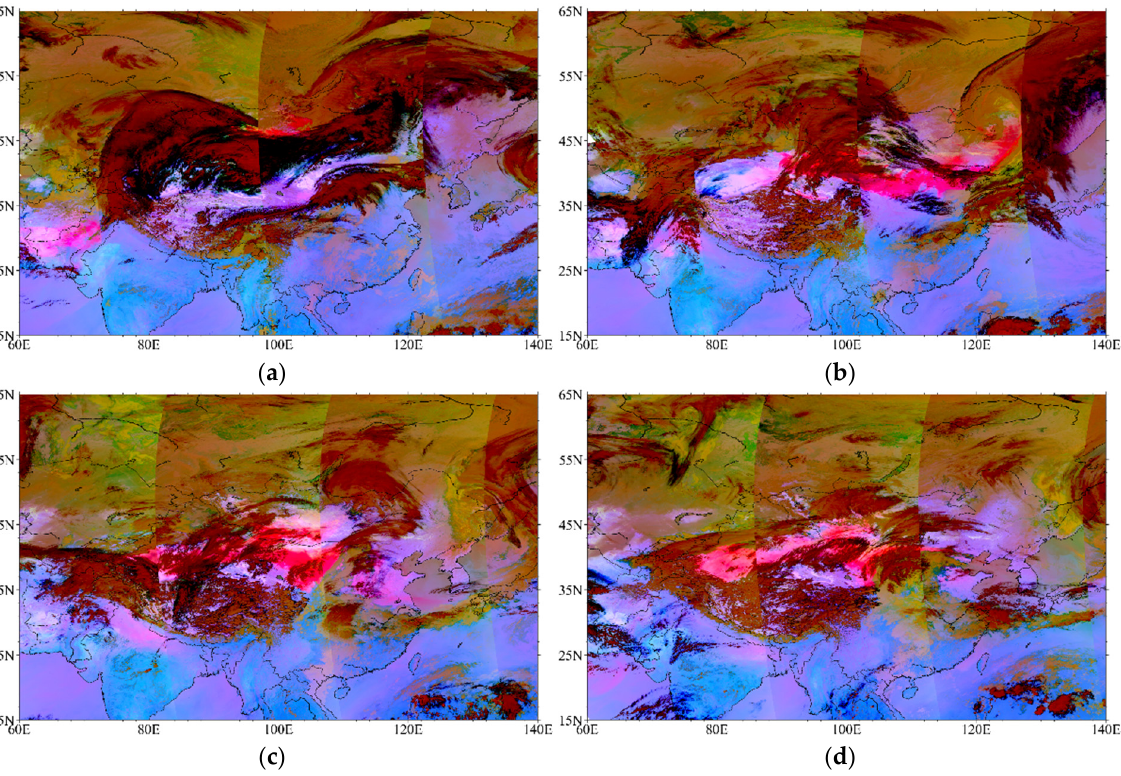
Figure 9. The VIIRS false-color RGB images of 14–17 March 2021. ( a ) 14 March 2021; ( b ) 15 March